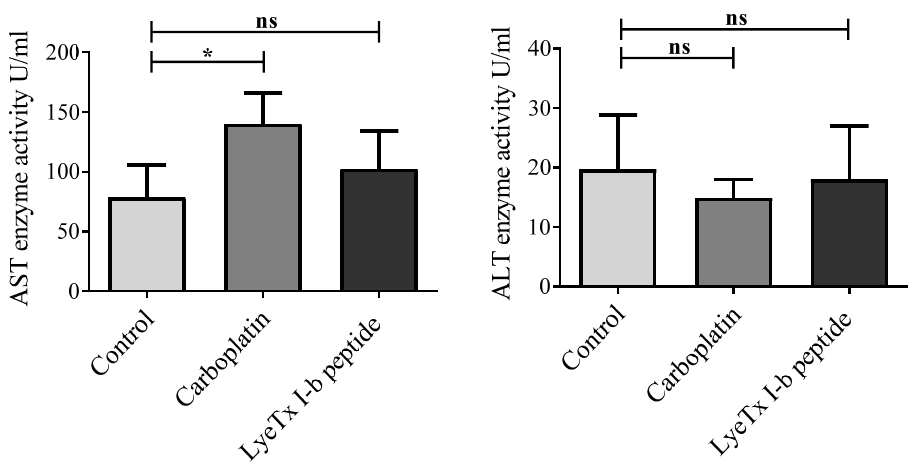
Figure 9. Plasma aspartate aminotransferase (AST) and alanine aminotransferase (ALT) activities in 4T1 tumor-bearing mice. Balb/c mice were injected subcutaneously 5 times, every 72 h, for 15 days with saline (control), LyeTX I-b (5 mg/kg), or carboplatin (5 mg/kg). AST and ALT levels were measured by using the colorimeter testing kit in triplicate, n = 6. Data represent the mean ± SD, One-way ANOVA followed by Tukey’s multiple comparisons test, * p < 0.05. ns: means not statistically significant.